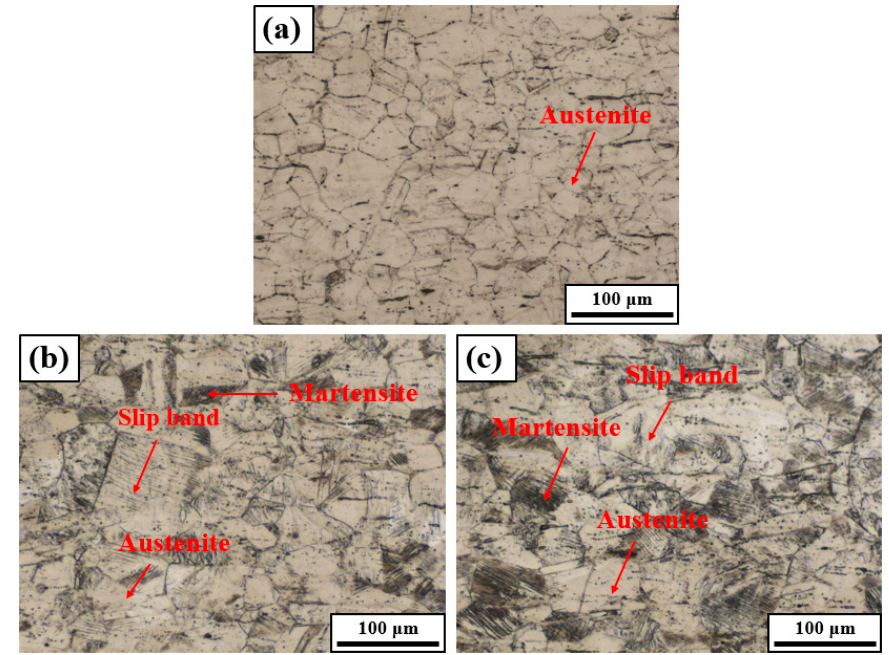
Figure 8. Metallographic structures of the specimens before and after wear at 800 magnification. ( a ) Nonworn surface, ( b ) worn surface I and ( c ) worn surface II.